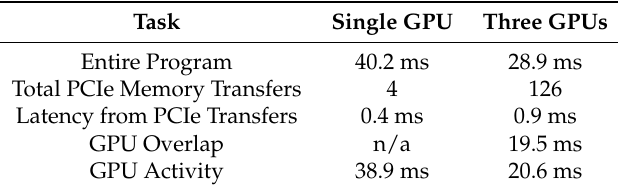
Table 8. Results of the multi-GPU